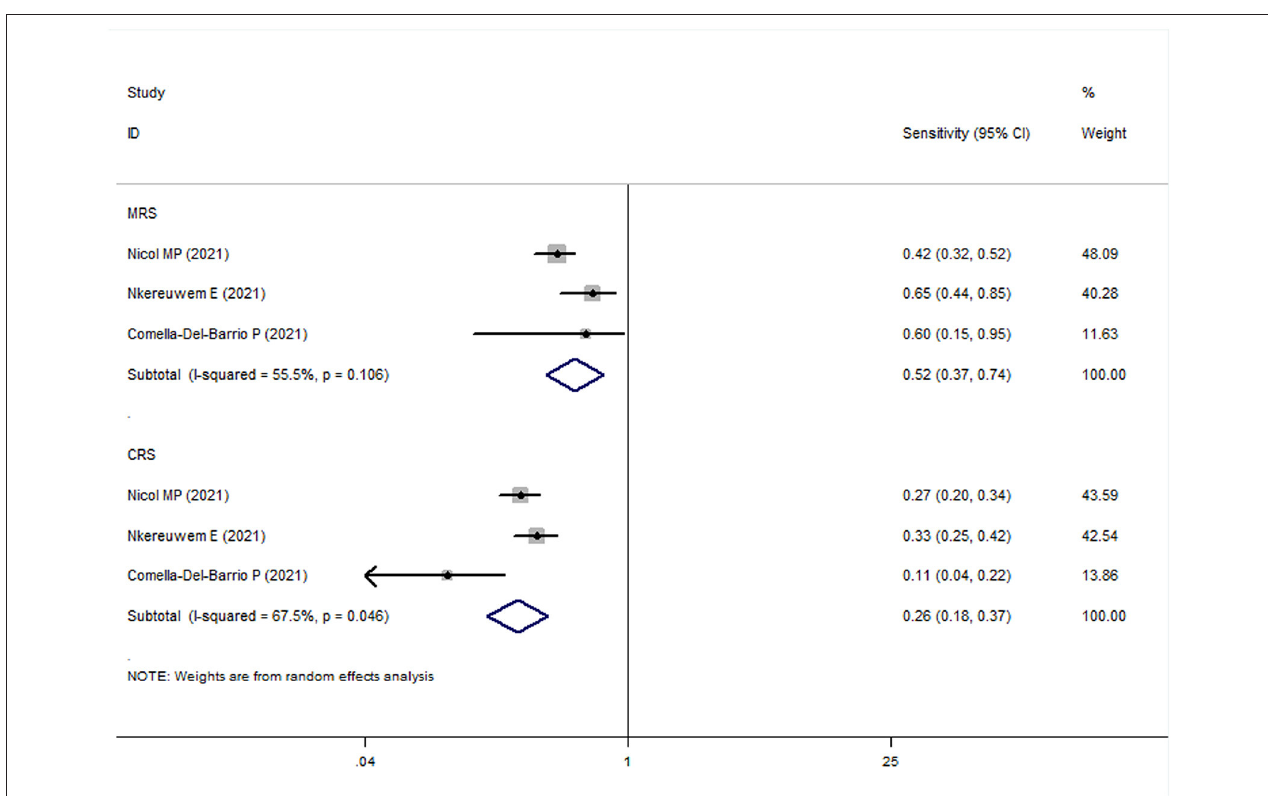
FIGURE 5 | The meta-analysis results of the sensitivity of FujiLAM in the diagnosis of pediatric patients with tuberculosis.